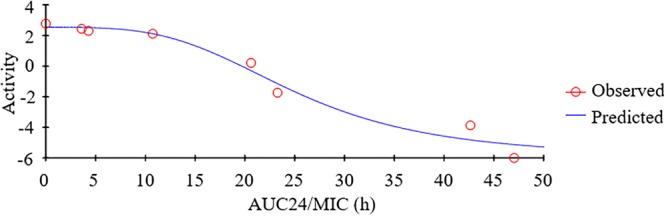
Plots of ex vivo AUC24 h/MIC ratios versus the amount of difference within 24 h.